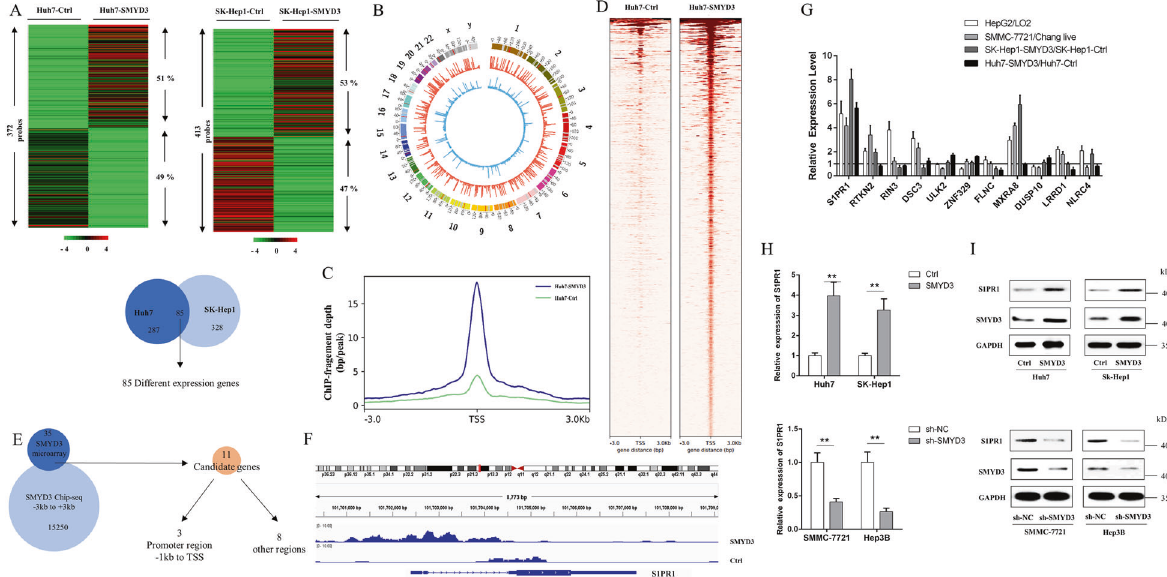
Fig. 3 SMYD3 regulated the expression of S1PR1. A Upper panel, the heat map of differentially expressed mRNAs in Huh7-SMYD3 cells compared with Huh7-Ctrl cells and in SK-Hep1-SMYD3 compared SK-Hep1-Ctrl cells ( ≥ 2-fold). The red color represents higher expression levels, and the green color represents lower expression levels (log 2 fold change). Lower panel, 85 candidate genes were selected after determining the overlap of the two datasets. B Circos plots showing genes on each of the 23 chromosomes with increased SMYD3 occupancy in ChIP-seq (Huh7-SMYD3 red compared with Huh7-Ctrl blue). C Pro fi le plot showing the distribution of indicated ChIP-seq signals around the TSS regions in cells overexpressing SMYD3. D Heat map of SMYD3 ChIP-seq binding pro fi les around TSS regions ( − 3 kb to 3 kb) in Huh7-Ctrl and Huh7-SMYD3 cells. E Venn diagram showing the overlap of SMYD3-upregulated genes and genes with SMYD3 binding sites at TSS ( − 3 kb to 3 kb) regions. F IGV (Integrative Genomics Viewer) pro fi le of SMYD3-enriched regions over the S1PR1 locus which was mainly at the promoter regions ( − 1 kb to the TSS). G mRNA expression levels of the 11 candidate genes in HepG2/LO2 (immortalized hepatocytes), SMMC- 7721/Chang live (immortalized hepatocytes), Sk-Hep1-SMYD3/Sk-Hep1-Ctrl (transiently transfected with SMYD3), and Huh7-SMYD3/Huh7-Ctrl cells (transiently transfected with SMYD3). H qPCR and ( I ) western blot analyses of S1PR1 expression in HCC cells with stable SMYD3 overexpression (Huh7-Ctrl vs. Huh7-SMYD3 and SK-Hep1-Ctrl vs. SK-Hep1-SMYD3) or stable knockdown (SMMMC-7721-sh-NC vs.